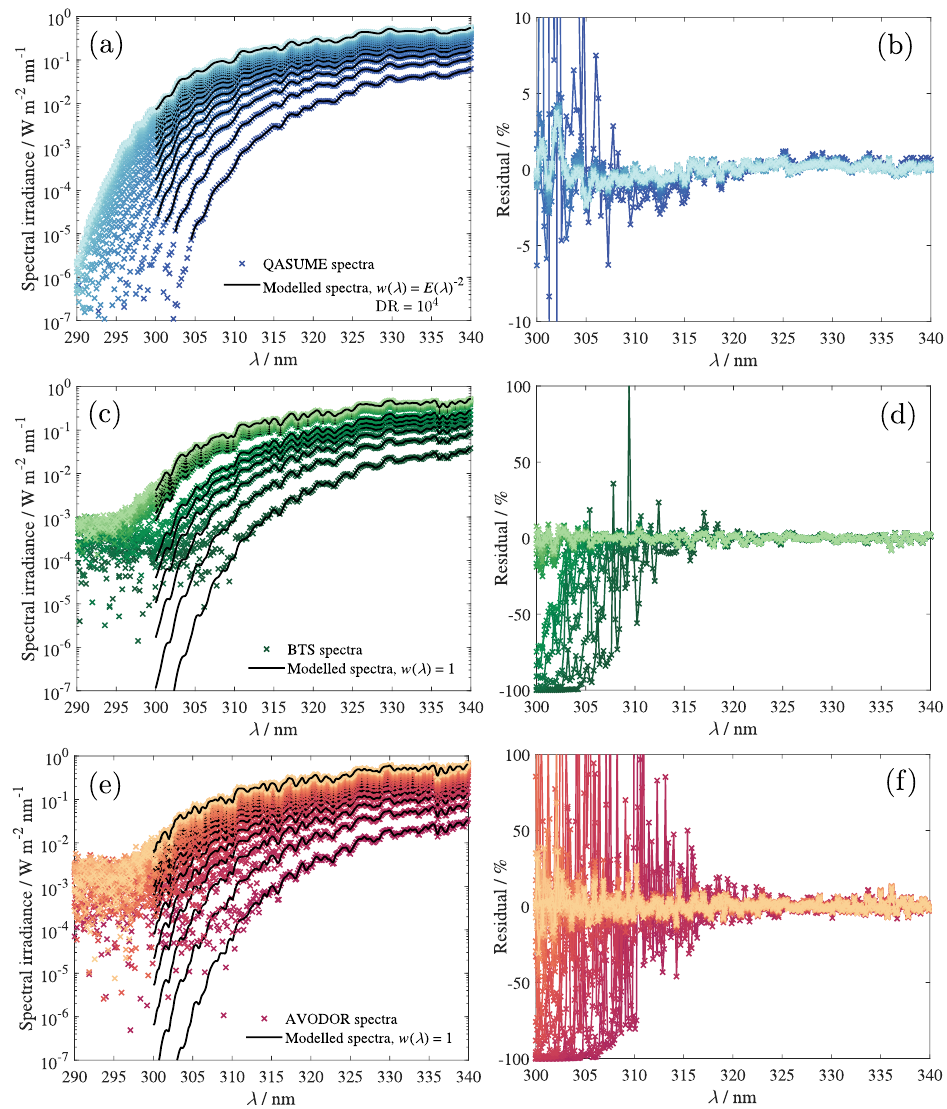
Figure 3. Examples of fitting the atmospheric model to the direct ground-based solar UV spectra between 300 and 340nm for QASUME (a–b) , BTS (c–d) , and AVODOR (e–f) . In figures on the left-hand side, the coloured symbols indicate measured spectra, and the black solid curves indicate modelled spectra. Figures on the right-hand side show the relative spectral residuals of the fits. In (a) the abbreviation DR refers to the dynamic range of QASUME data used in the least squares